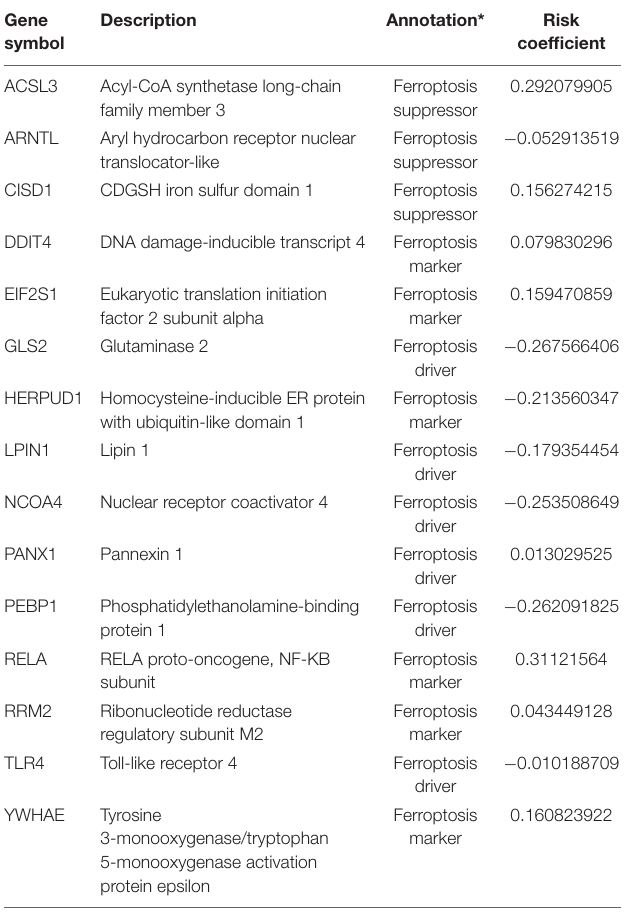
TABLE 3 | Fifteen ferroptosis-related prognostic genes obtained from LASSO Cox regression